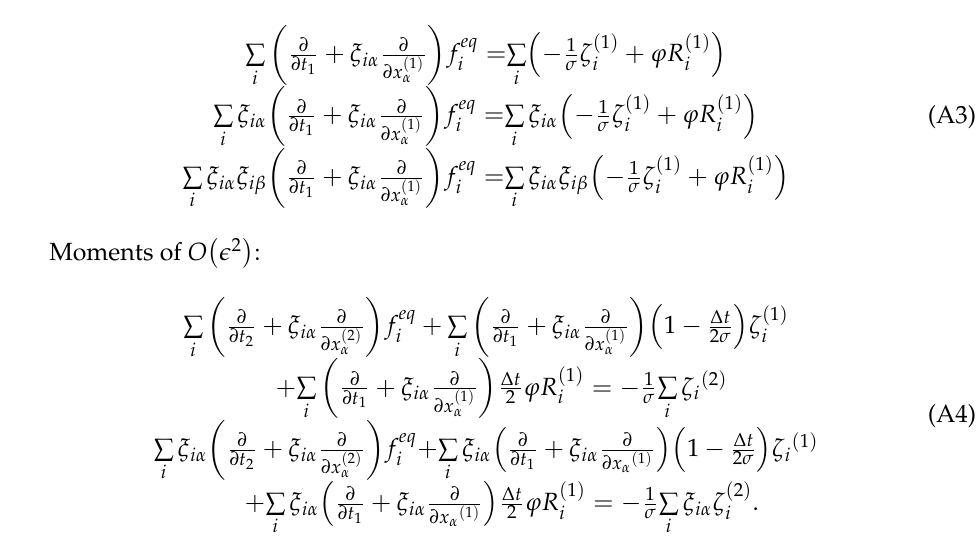
Table A1. Mathematical expressions for the moments of the discrete forcing terms R i for the three considered forcing schemes.